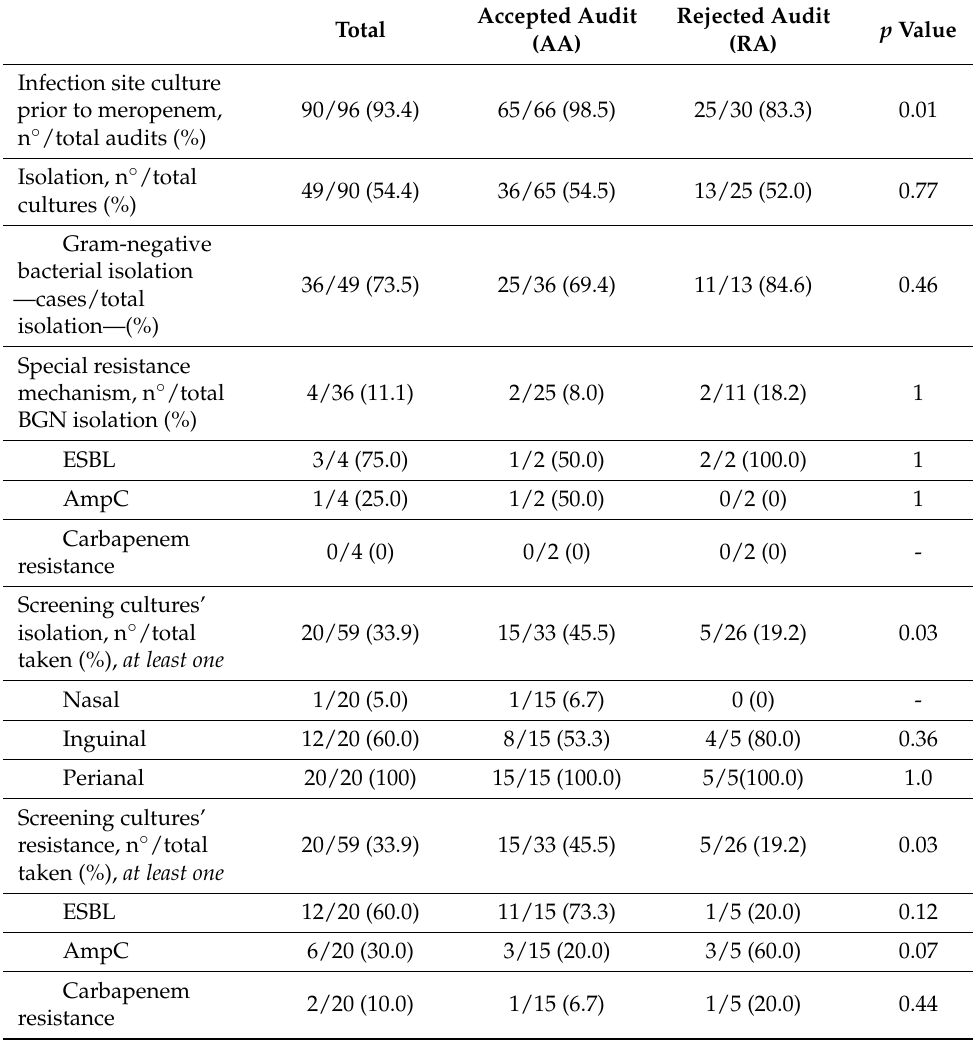
Table 2. Microbiological